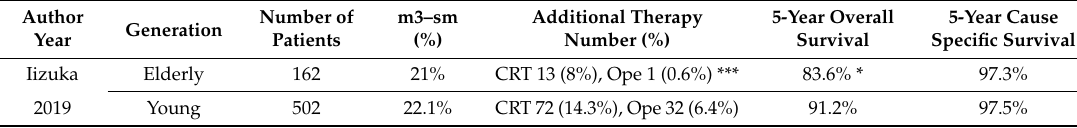
Table 3. Comparison between the elderly and the younger generation after esophageal ESD.